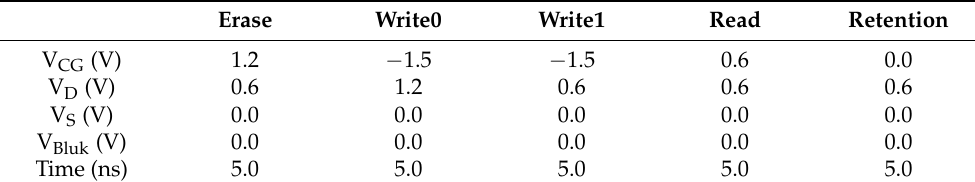
Table 1. The operation parameters of the HDM.